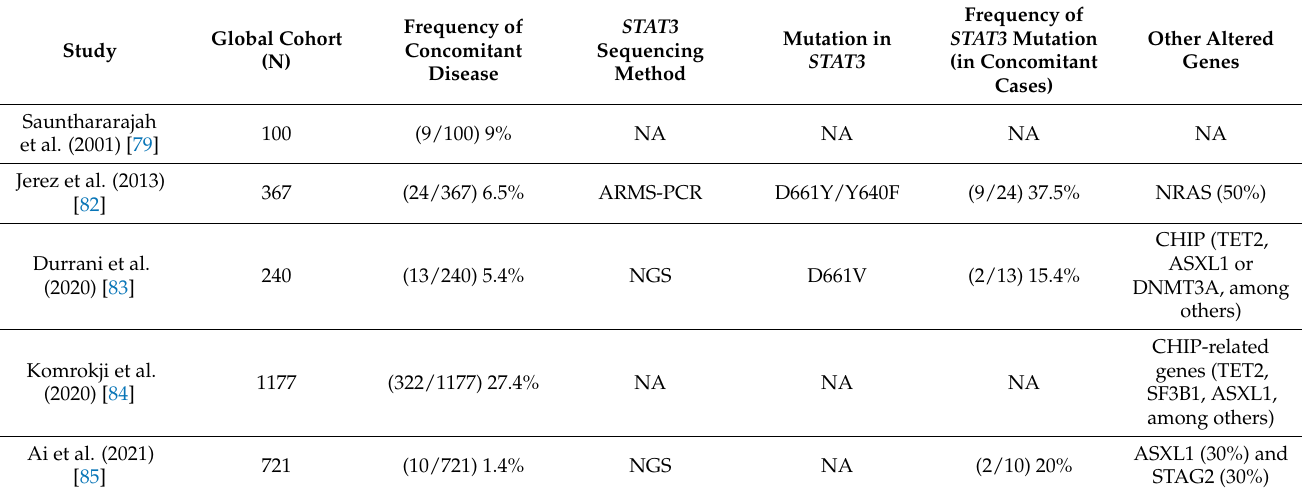
Table 3. LGLL diagnosis in MDS